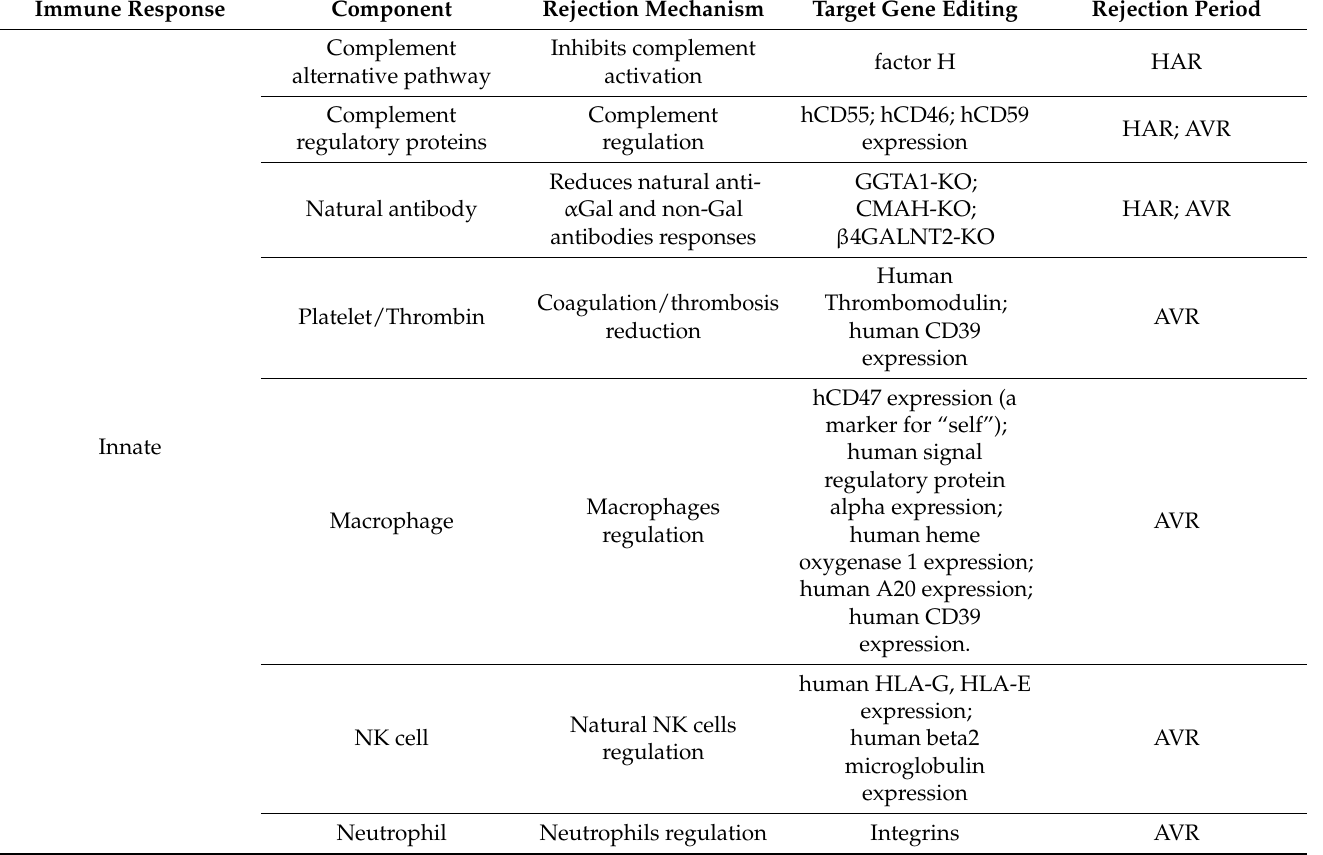
Table 1. Components of innate immunity that recognize a